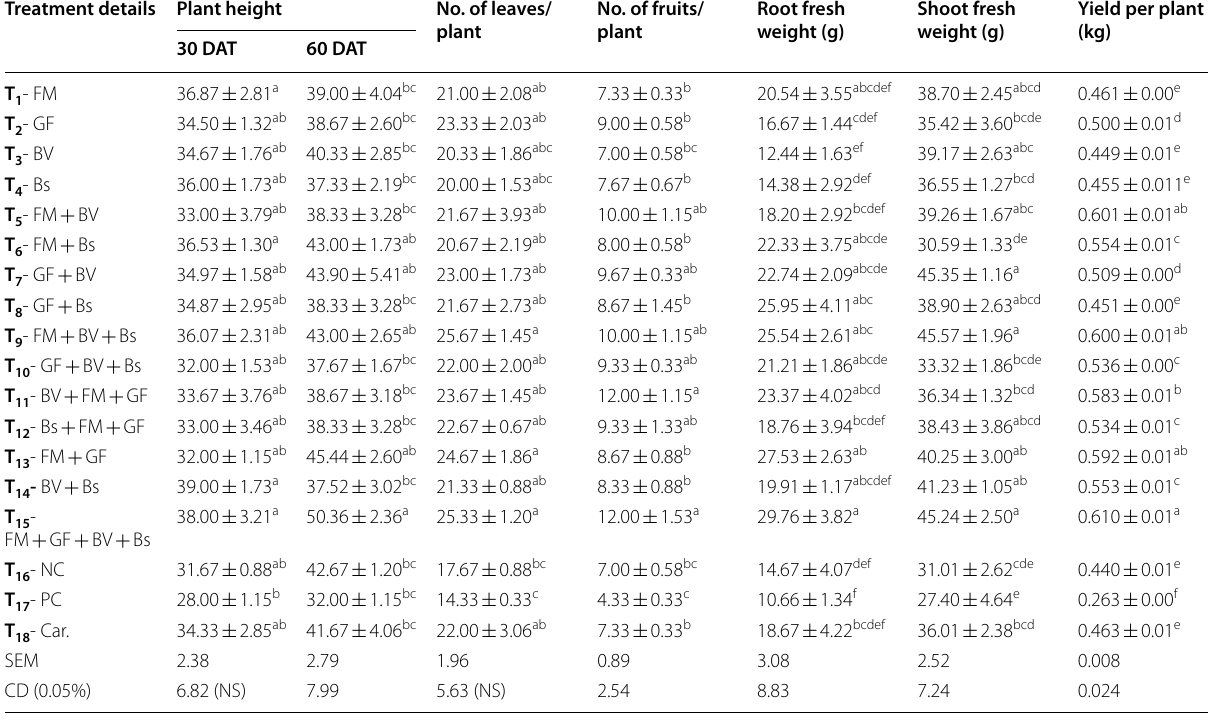
Values with different letter(s) within a column are significant at p< 0.05 by Duncan’s multiple range test (DMRT), Values are the means ( replicates